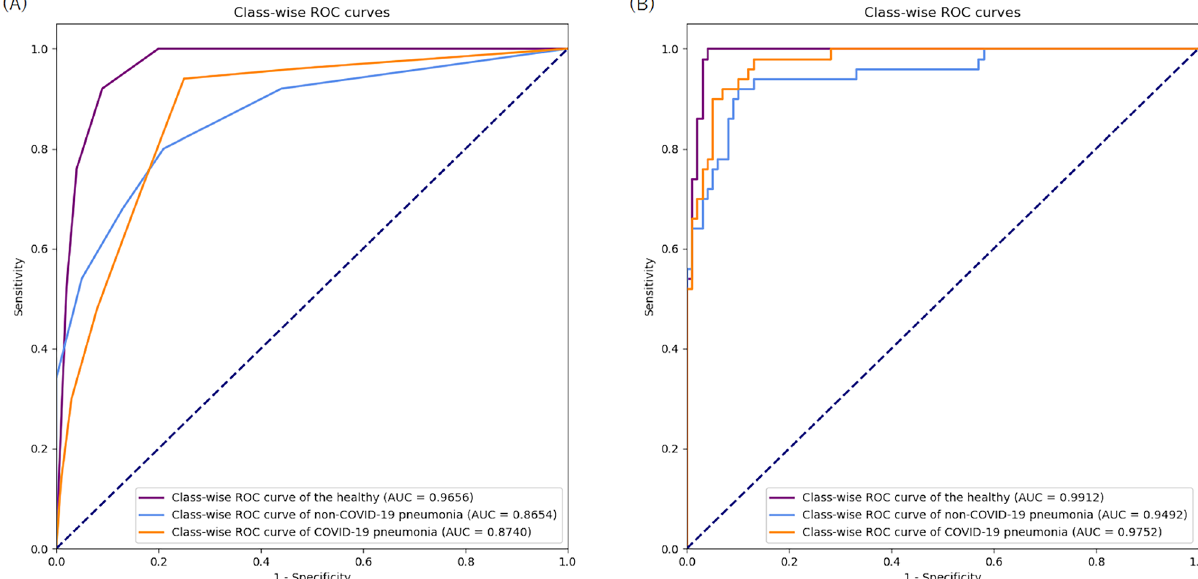
Figure 3. Class-wise ROC curves in COVID private dataset. Note: ( A ) consensus of radiologists and ( B ) our DL model. Abbreviation: DL, deep learning; COVID private , private dataset collected from six hospitals; AUC, area under the curve; ROC, receiver operating